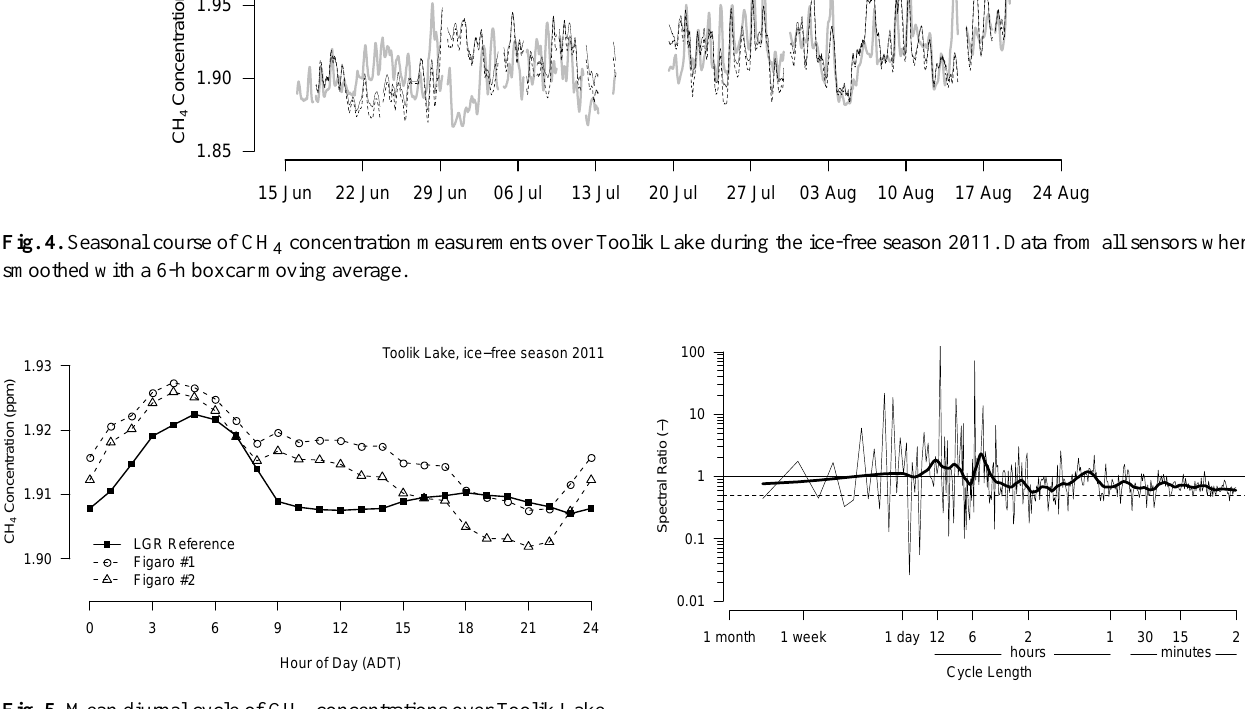
Fig. 6. Spectral densities of solid-state sensor #2 standardized by those measured by the Los Gatos Research reference analyzer dur- ing the longest period without data gaps (30 July to 14 August 2011). Calibrated data aggregated to 1-min averages were fast Fourier transformed, then bin-averaged to 200 bins of equal width on the log frequency axis, and then expressed as a ratio. The bold line is a local polynomial regression fit (loess function in R with α =0.12; N =22142). Frequencies are labeled with their respective cycle lengths. At cycle lengths < 1h, the solid-state sensor still cap- tures more than 50% (dashed line) of the variance of the reference instrument. At cycle lengths > 6h, a relatively good agreement was